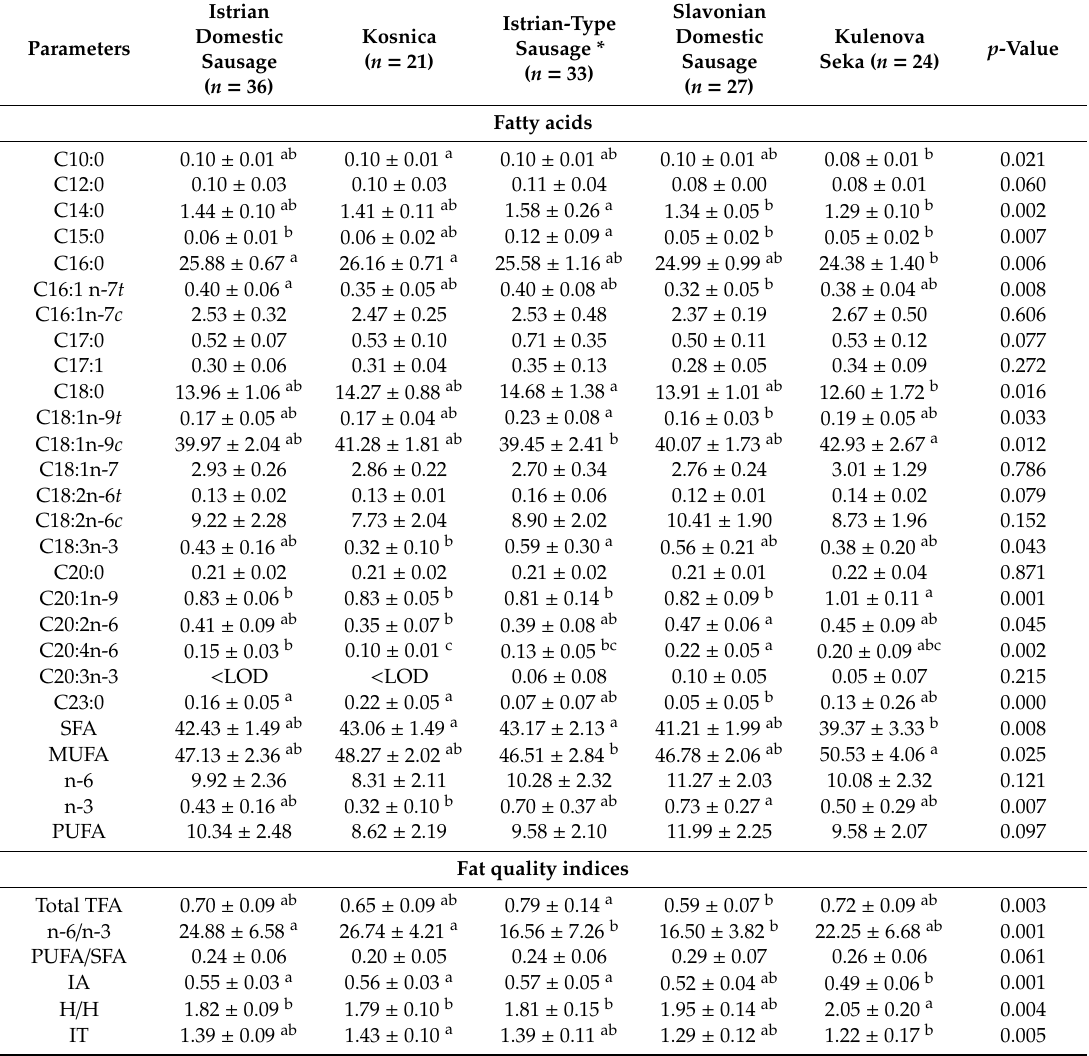
Table 5. Fatty acids and fat quality indices descriptive of Croatian traditional dry-fermented